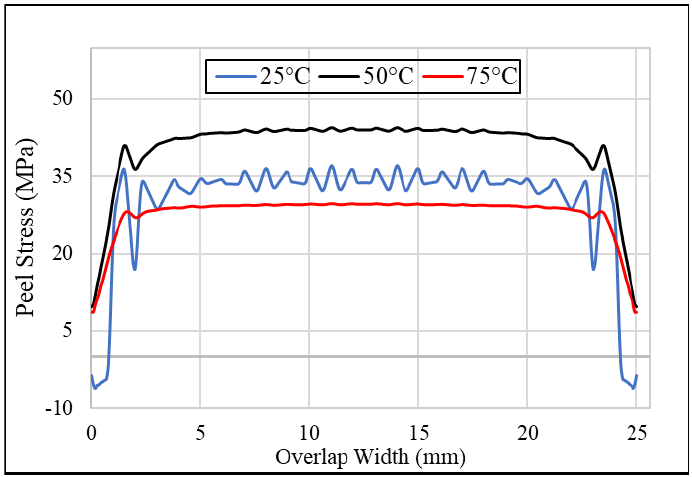
Figure 8. Peel stress distribution at location C of SLJ with neat adhesive at different temperatures.